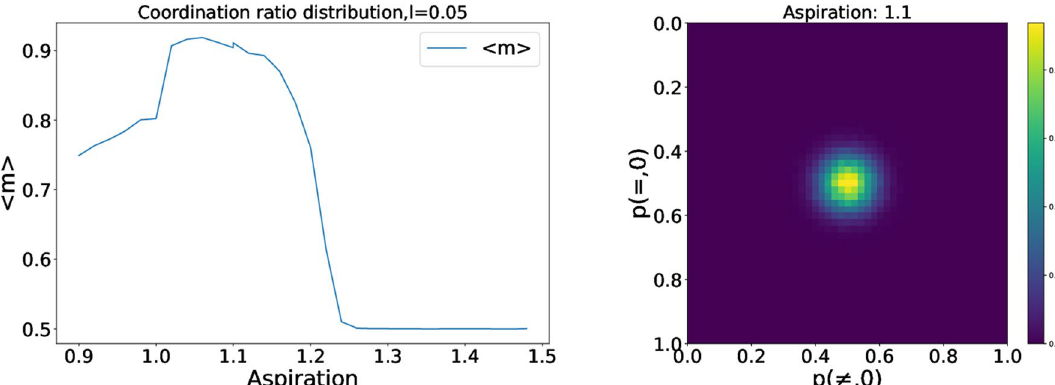
Figure 5. Left: Coordination ratio m i for different values of the aspiration, averaged over agents, time and simulations. Right: 2D histograms for the probability vectors of the population. l = 0.05 .